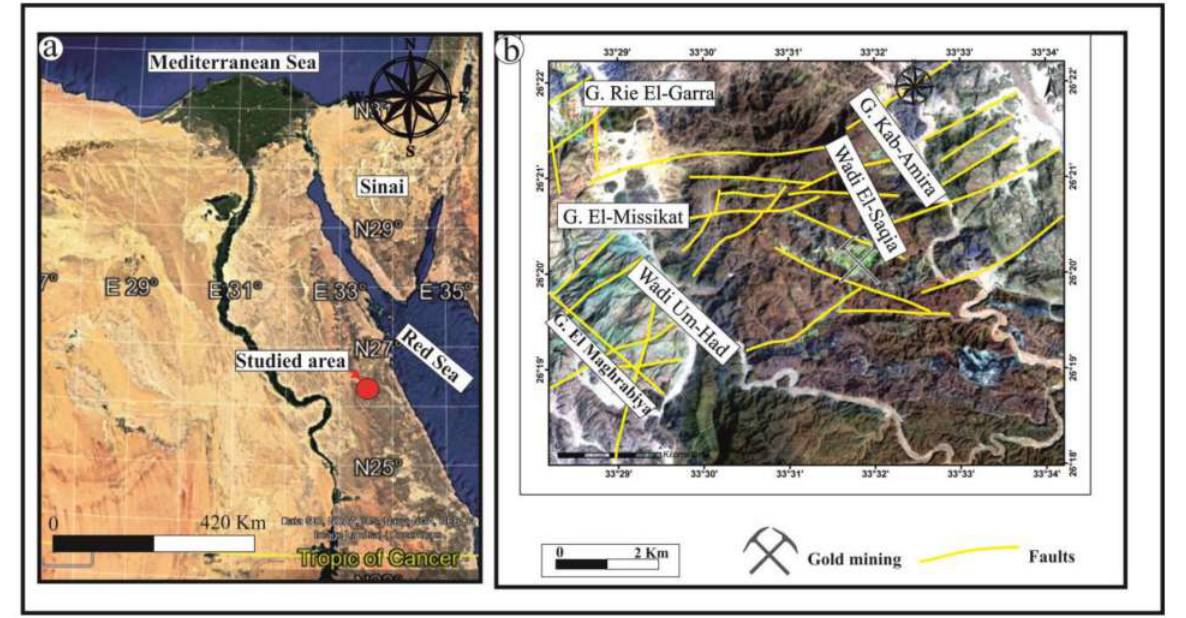
Figure 1. ( a ) Wadi El-Saqia location map. ( b ) Landsat R–G–B band combination image 5–3–2 of Wadi El-Saqia and its surroundings, illustrating the locations of surface structures and of the gold mine.